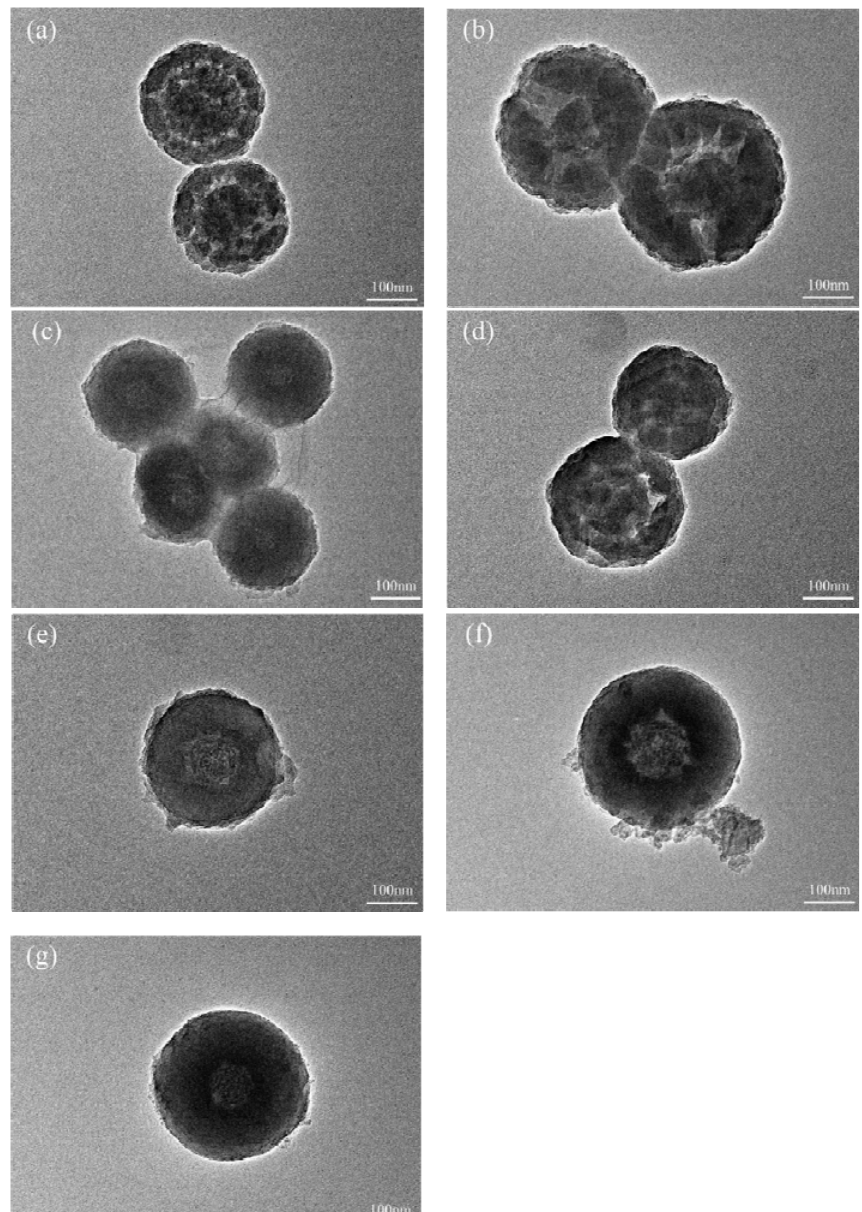
Figure 6. TEM micrographs of the nanocapsules: ( a ) NeIN1; ( b ) NeIN2; ( c ) NeIN3; ( d ) NeIN4; ( e ) NeIN5; ( f ) NeIN8; ( g ) NeIN9.